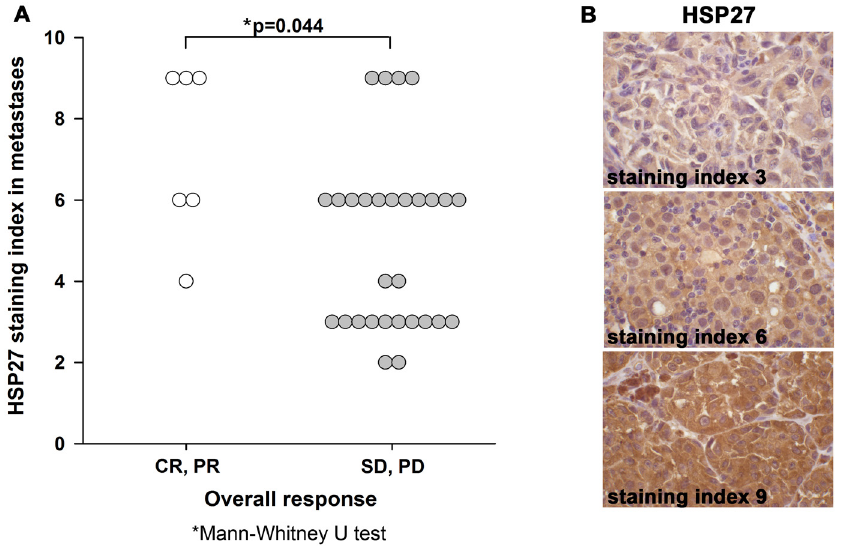
Fig 1. HSP27 expression in metastases predicts overall response to treatment with bevacizumab. (A) HSP27 expression in metastases grouped by treatment response. CR: complete clinical response, PR: partial response, SD: stable disease, PD: progressive disease. (B) Examples for low, moderate and high staining index for HSP27. Original magnification x630.